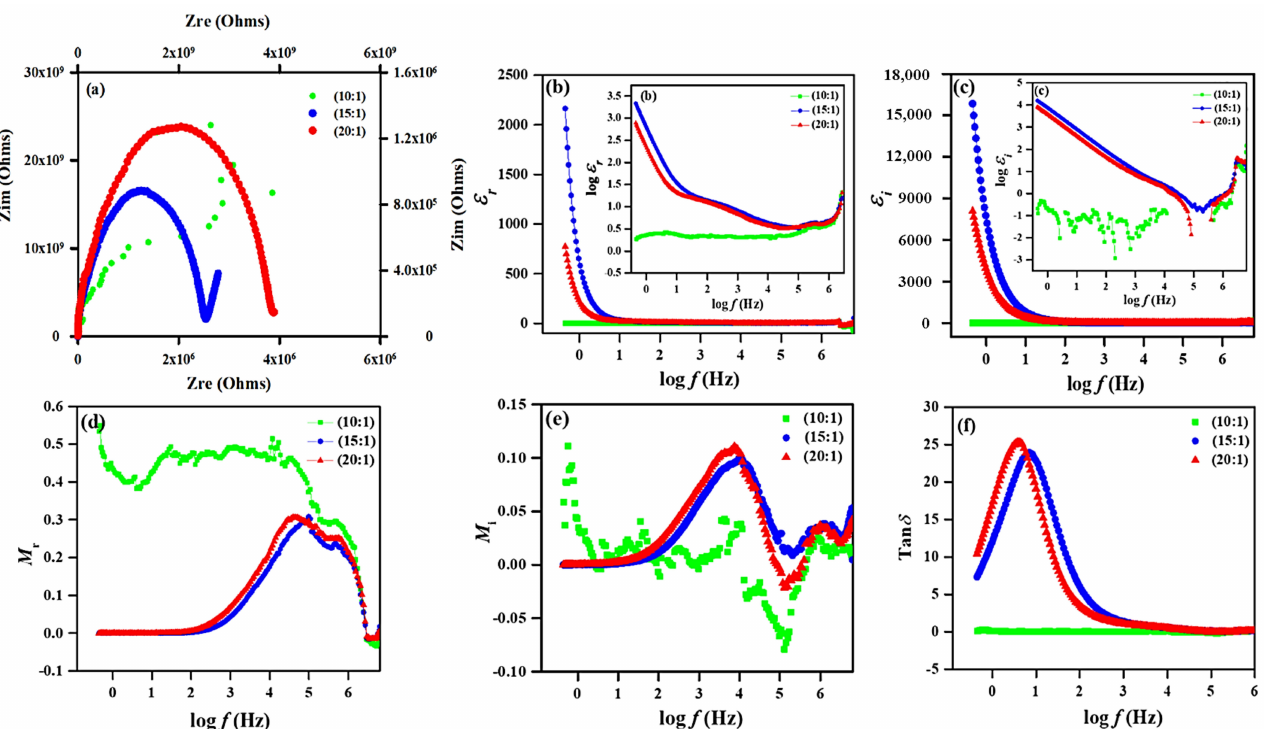
Figure 9. Variation in ( a ) impedances, ( b ) ε r , ( c ) ε i , ( d ) M r , ( e ) M i , and ( f ) tan δ as a function of frequency (0.1 Hz–1 MHz) of ACN- g -ENR products with different mole ratios and room